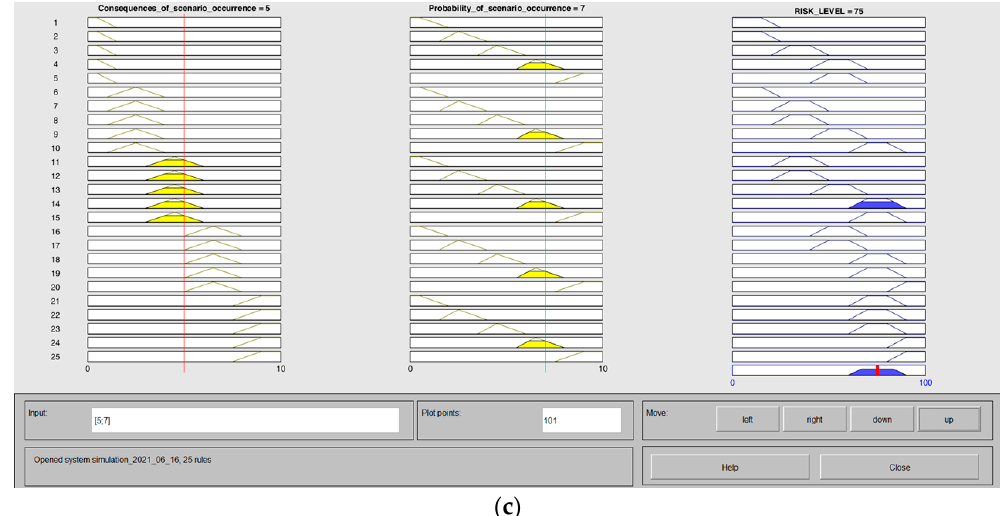
Figure 8. Mamdani algorithm in Matlab: ( a ) general view of the model; ( b ) FIS engine; ( c ) sample rule base.